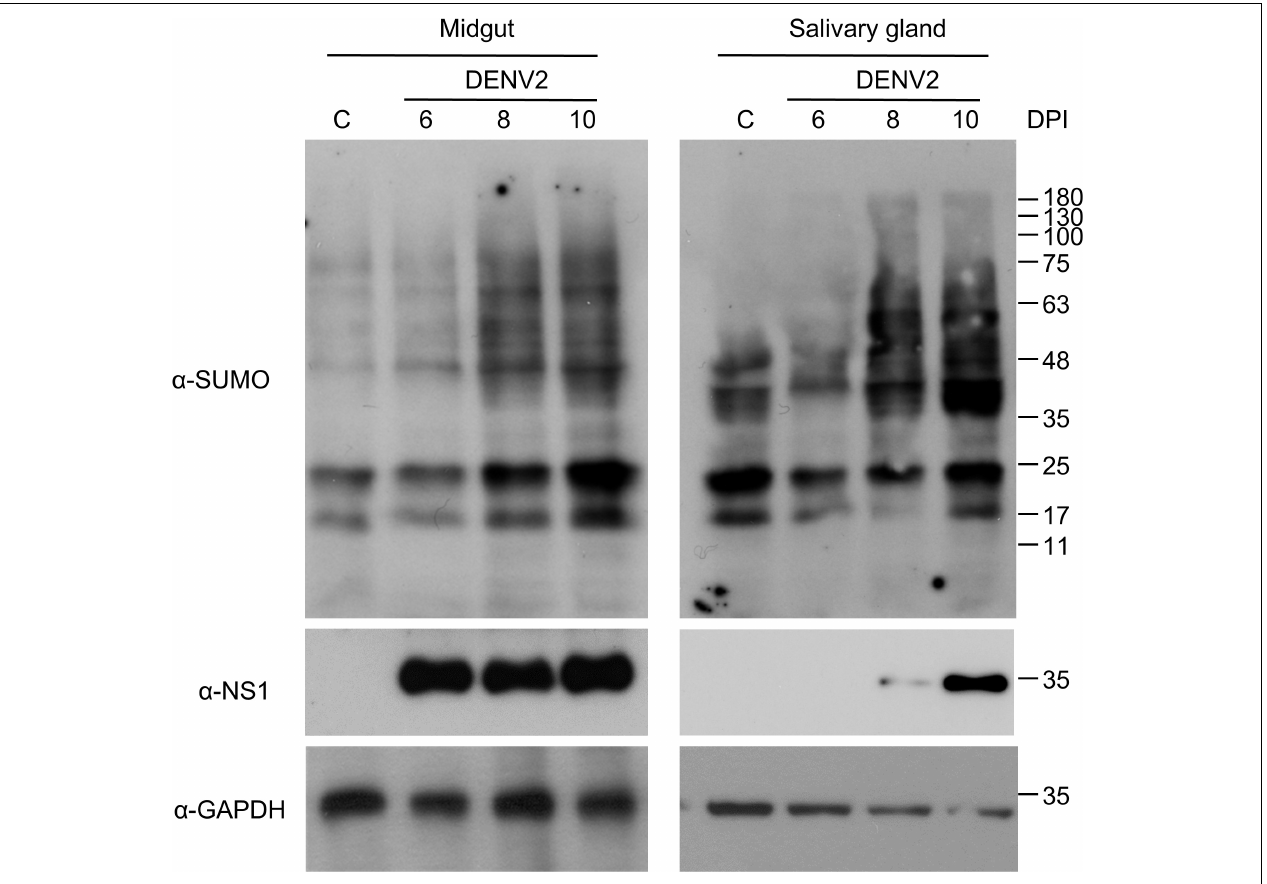
FIGURE 3 | Protein SUMOylation is activated after a blood meal in the midgut of mosquitoes. Three-day-old female mosquitoes were fed with DENV2 infectious blood meal (10 7 pfu/ml). At 6, 8, or 10 days post blood feeding the midgut and salivary gland were dissected, and the protein levels of SUMO and DENV2 NS1 protein were analyzed by western blot with anti-SUMO or anti-NS1 antibodies. GAPDH was used as an internal